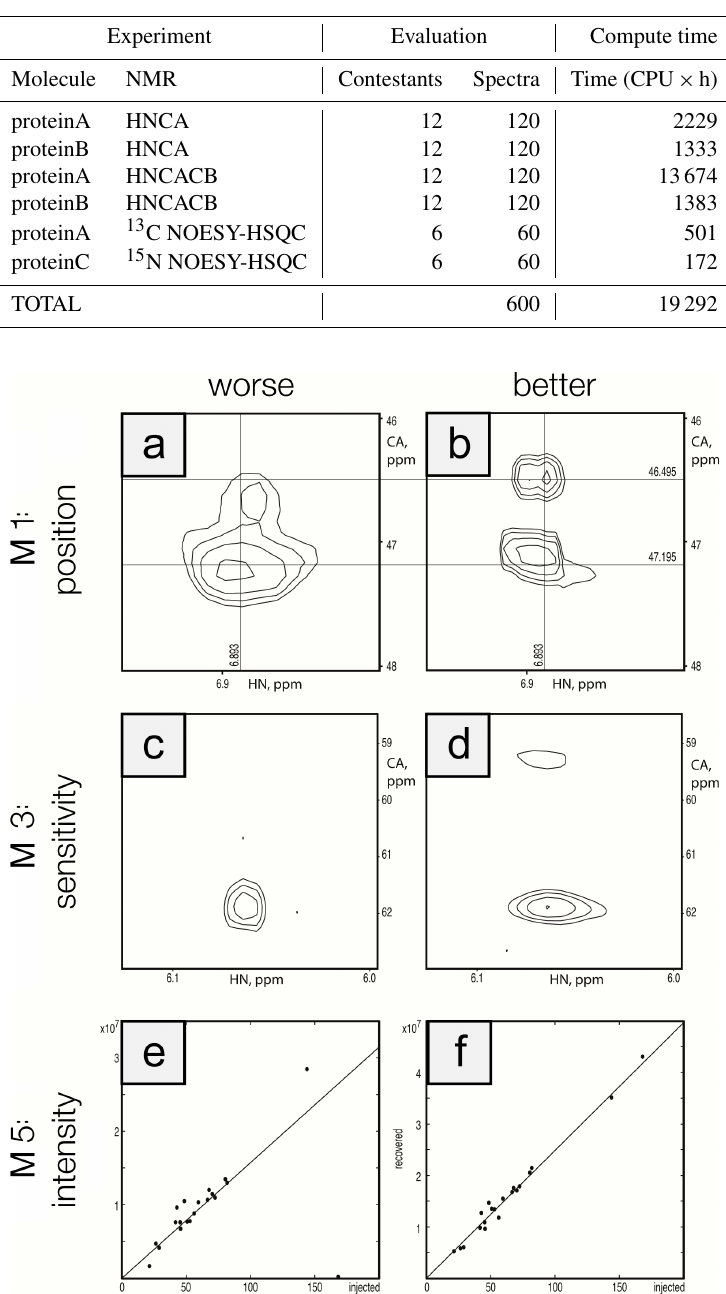
Table 5. Summary of computations. The number of spectral reconstructions and the compute times they required. Most of the reconstruction methods are multi-threaded, and all computations are spread across 10 NMRbox VMs to yield a substantial reduction in the “wall time” for completing the evaluations.